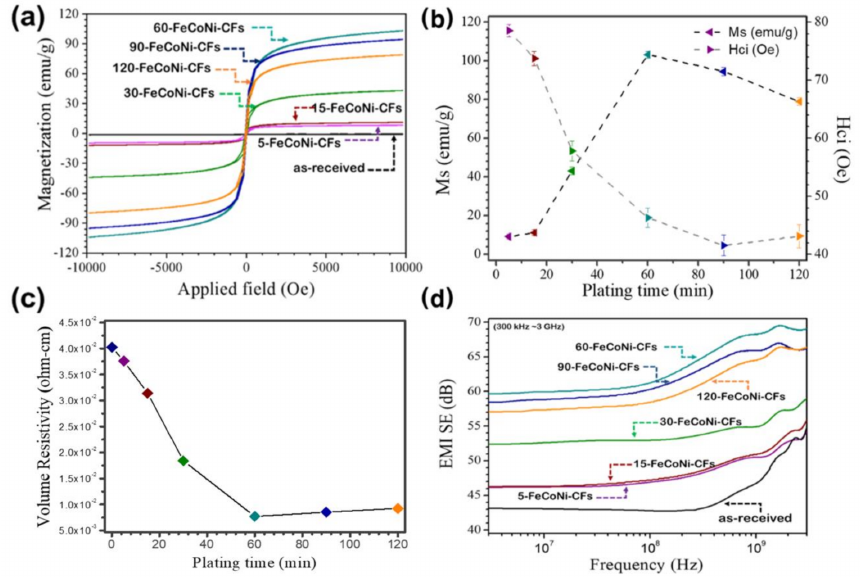
Figure 6. ( a ) Hysteresis loops, ( b ) magnetization saturation (Ms) and coercivity (Hc), ( c ) volume resis- tivity, and ( d ) EMI SE effectiveness of as-received CFs and FeCoNi-CFs as a function of plating